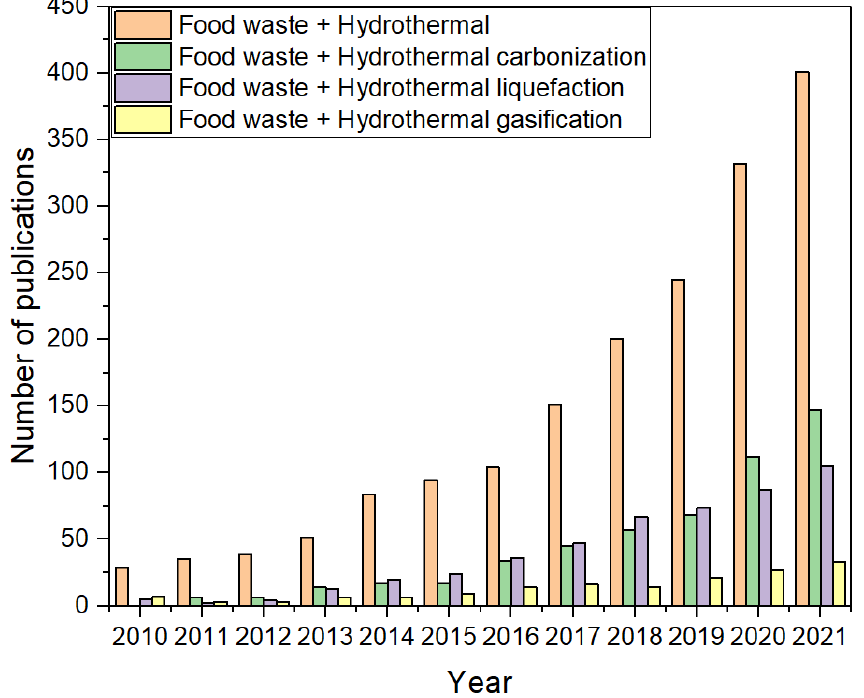
Figure 1. Science Citation Indexed publications on the hydrothermal treatments of food waste in Web of Science.